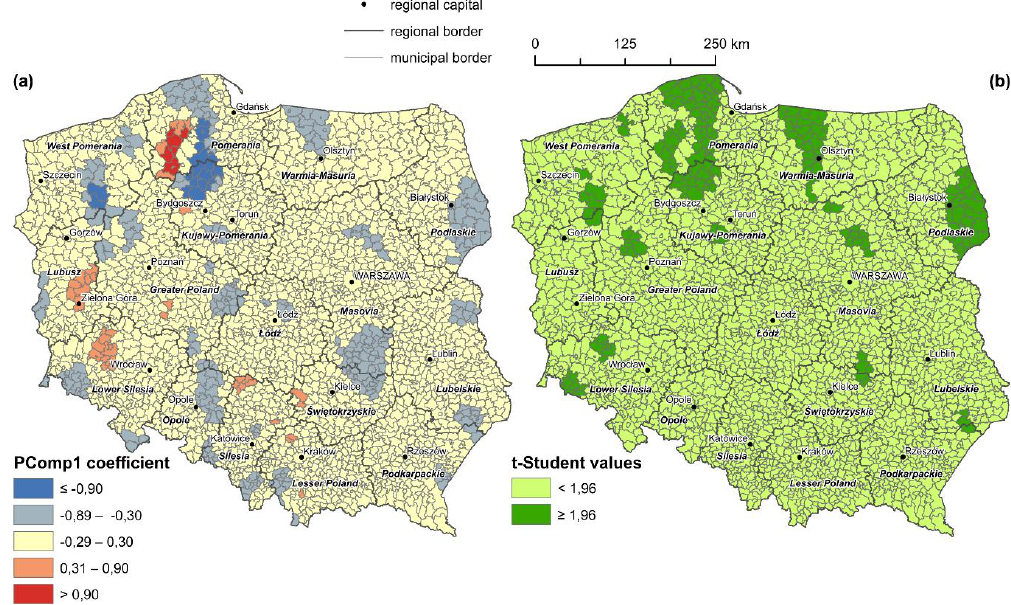
Figure 5. Value ( a ) and significance ( b ) of impact of the first component “urbanisation and EU support” on land cover changes in Poland, in the years 2012–2018.